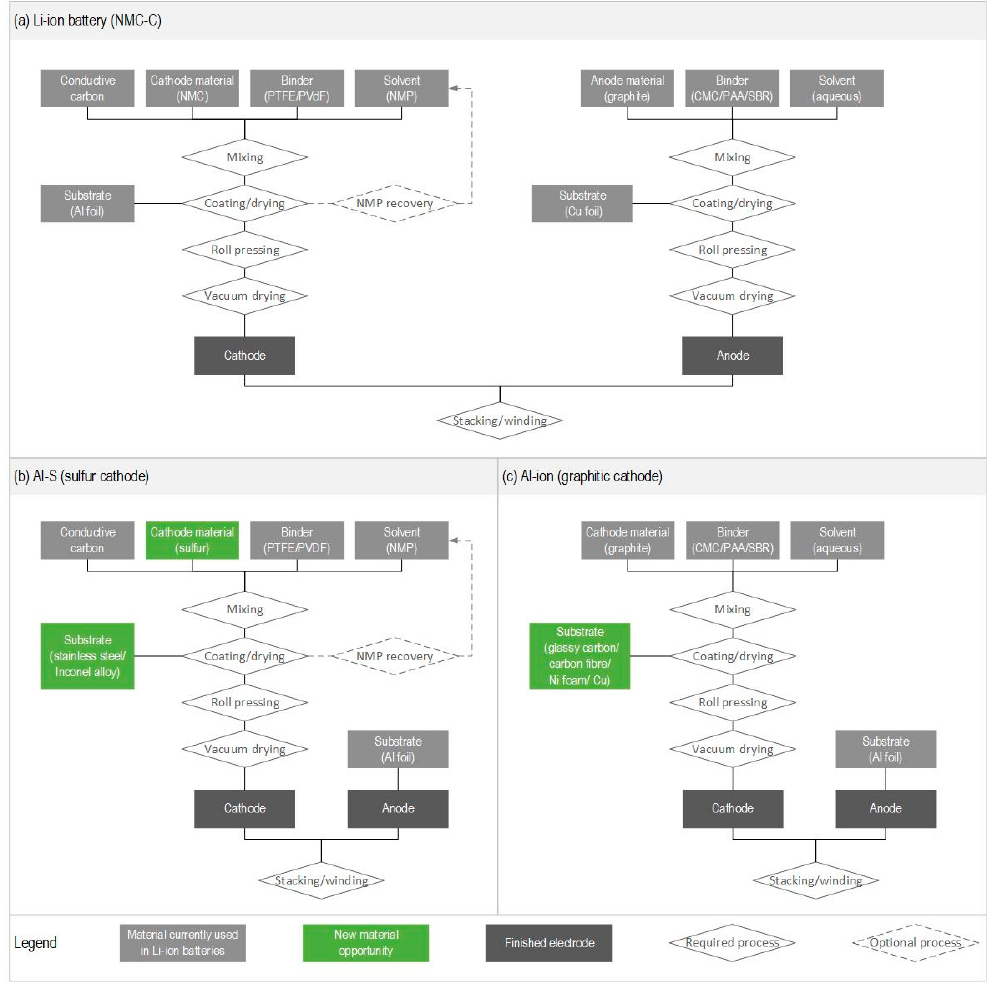
Figure 2. Electrode production requirements for ( a ) a Li-ion battery with NMC cathode and graphitic anode; ( b ) an Al-S battery with sulfur cathode and aluminum anode; and ( c ) an Al-ion battery with graphitic cathode and aluminum anode. Abbreviations: NMC—lithium nickel-manganese-cobalt oxide, PTFE—polytetrafluoroethylene, PVDF—polyvinylidene difluoride, NMP— N -methyl-2-pyrrolidone, CMC—carboxymethyl cellulose, PAA—polyacrylic acid, and SBR—styrene butadiene